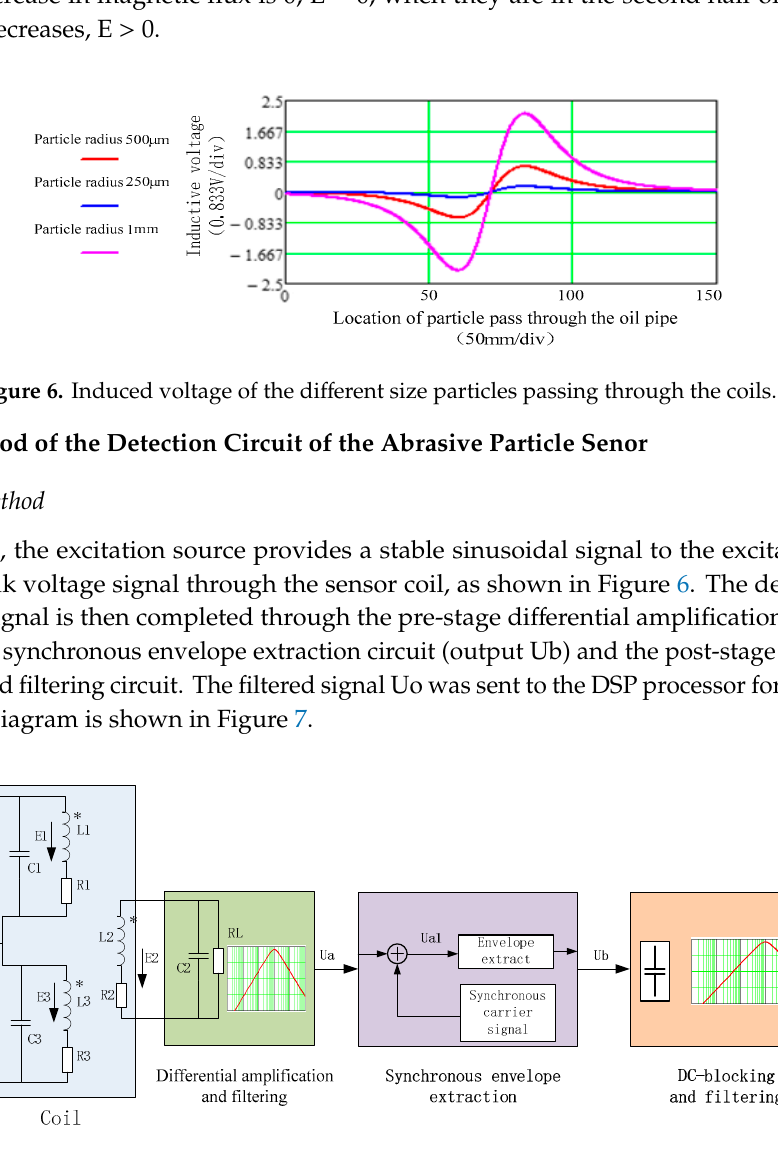
Figure 5. Relationship between the induced voltage and abrasive particle radius.